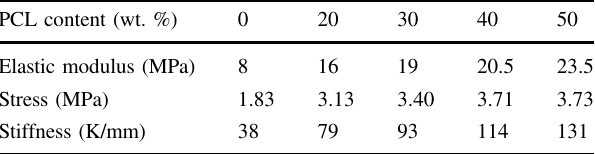
Table 2 Mechanical properties of the composite Scaffolds GEL/HA with a different weight percentage of PCL content [67] PCL content (wt. %)